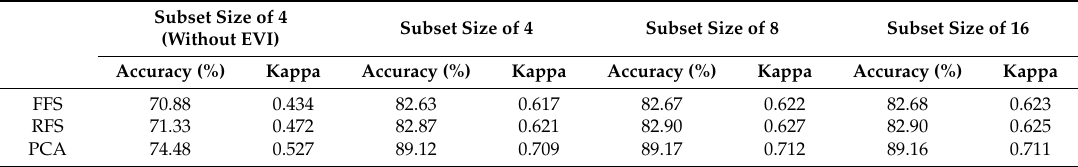
Table 6. The accuracy and Kappa coefficient for FFS, RFS and